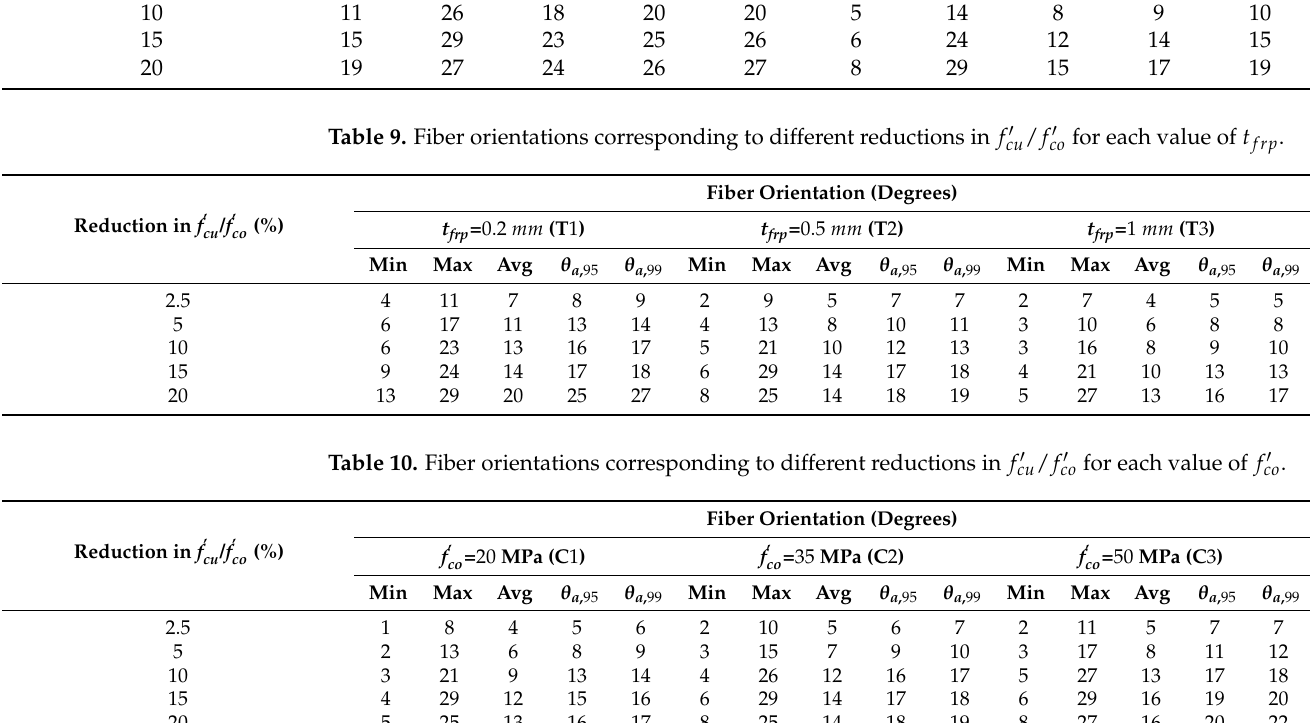
Reduction in f ’ / f ’ (%) Table 8. Fiber orientations corresponding to different reductions in 𝑓 (cid:3030)(cid:3048)(cid:4593) /𝑓 (cid:3030)(cid:3042)(cid:4593) for each value of 𝐸 (cid:3033)(cid:3045)(cid:3043) . cu co